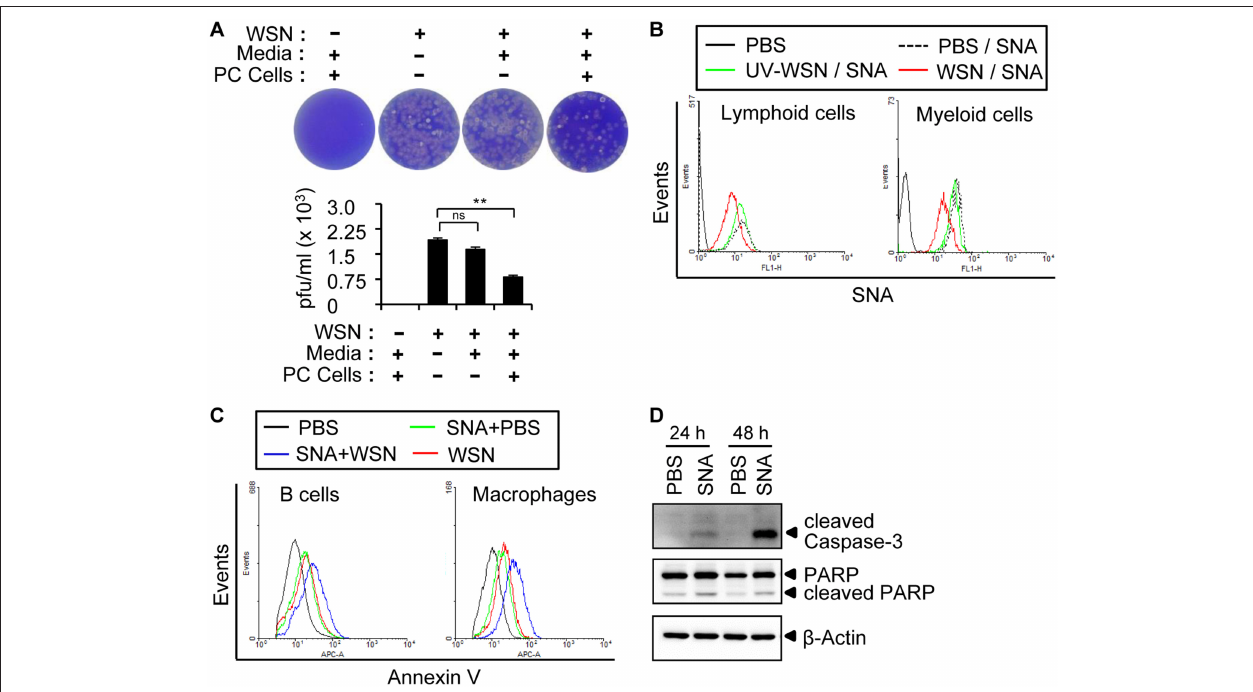
FIGURE 4 | A/WSN/1933 virus binds to peritoneal cells. (A) Peritoneal cells were harvested from BALB/c mice ( n = 3) and seeded into 5ml round-bottom tubes (1 × 10 6 cells in 1ml). The tubes were treated with PBS or A/WSN/1933 virus (WSN, 3 × 10 3 pfu). After 1h of incubation at 4 ◦ C, the supernatant was separated by centrifugation and 100 µ l of the supernatant was seeded along with MDCK cells in 6-well plates, incubated for 72h, and stained with crystal violet, and plaques were counted. ns, not significant. ** P < 0.005. (B) Competitive binding of A/WSN/1933 virus and SNA to α -2,6-linked sialic acids of peritoneal cells. Peritoneal cells (1 × 10 6 ) were incubated with 1 × 10 6 pfu of A/WSN/1933 virus or UV-WSN virus for 1h at 4 ◦ C and then treated with fluorescein-conjugated SNA for 1h at 4 ◦ C. The cells were stained with fluorescence-conjugated antibodies (CD19 and B220 for lymphoid cells, CD11b for F4/80 myeloid cells) and then analyzed by flow cytometry. (C) Peritoneal cells were incubated in 24-well plates with SNA for 1h at 37 ◦ C and then treated with PBS (SNA + PBS), or 1 × 10 6 pfu of A/WSN/1933 virus (SNA + WSN) for 72h. Peritoneal cells treated with PBS only or A/WSN/1933 virus plus PBS were used as controls. The cells were stained with fluorescence-conjugated antibodies (CD19 and B220 for lymphoid cells, CD11b and F4/80 for myeloid cells) and Annexin V and then analyzed by flow cytometry. Triplicate experiments were carried out. (D) Expression of apoptotic proteins (cleaved Caspase-3 and cleaved PARP) in the PBS-treated control and SNA-treated peritoneal cells was determined by western